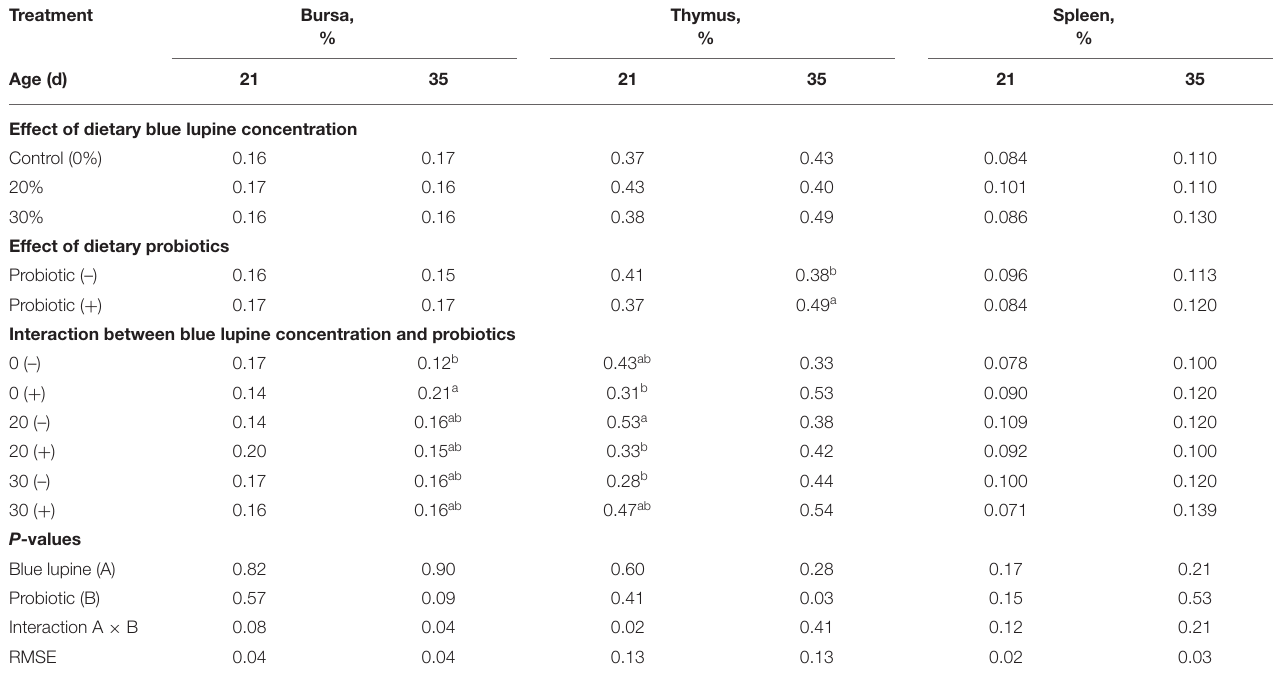
TABLE 6 | Effect of blue lupine and probiotics on the internal body organs of broiler chickens at 21 and 35 d of age. Treatment Bursa,